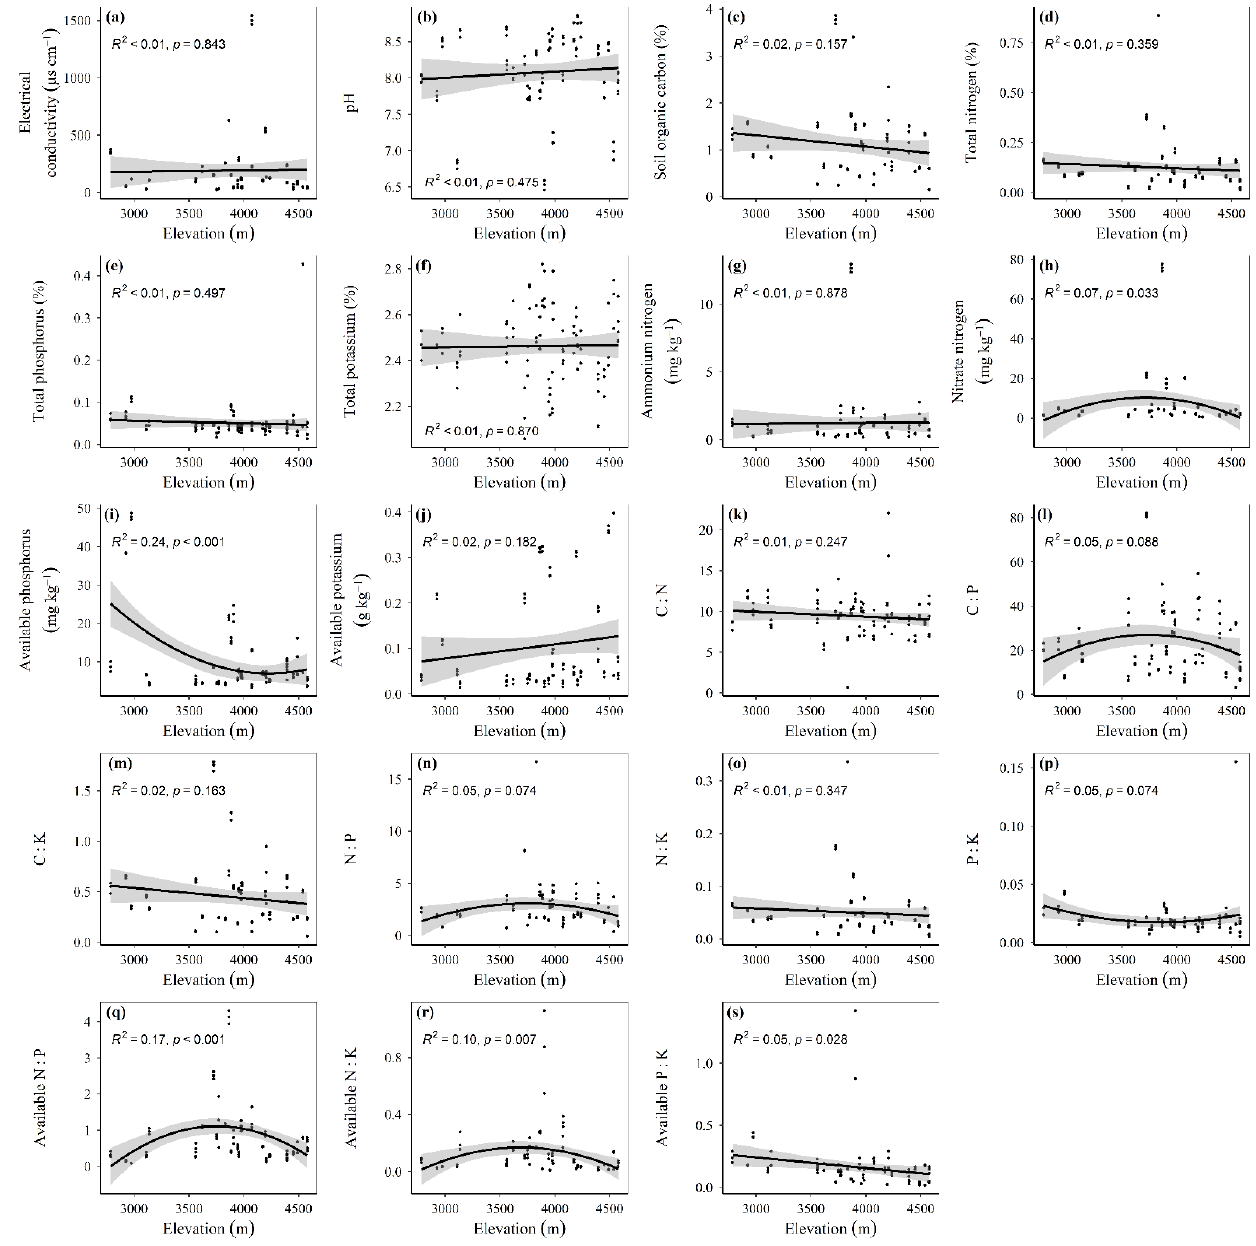
Figure A5. Relationships of elevation with soil ( a ) electrical conductivity, ( b ) pH, ( c ) soil organic carbon (SOC), ( d ) total nitrogen (TN), ( e ) total phosphorus (TP), ( f ) total potassium (TK), ( g ) ammonium nitrogen (NH 4+ -N), ( h ) nitrate nitrogen (NO 3 − -N), ( i ) available phosphorus (AP), ( j ) available potassium (AK), ( k ) ratio of SOC to TN (C:N), ( l ) ratio of SOC to TP (C:P), ( m ) ratio of SOC to TK (C:K), ( n ) ratio of TN to TP (N:P), ( o ) ratio of TN to TK (N:K), ( p ) ratio of TP to TK (P:K), ( q ) ratio of available nitrogen to AP (available N:P), ( r ) ratio of available nitrogen to AK (available N:K) and ( s ) ratio of AP to AK (available P:K) at a depth of 10–20 cm.